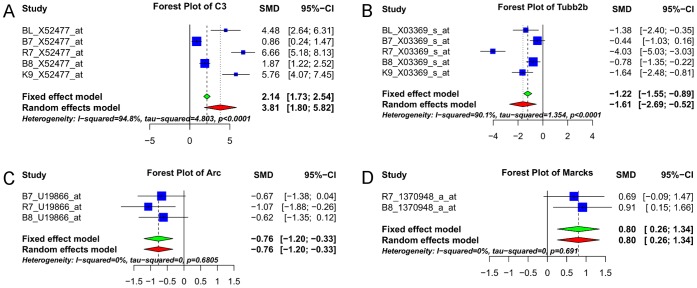
Forest plots of four representative significant genes.For the selected probe-set for each gene the individual study specific standardized mean differences (SMD) and their 95% confidence intervals (CI) are plotted and shown on each row. The effect size results are shown at the bottom of each plot. C3 is up-regulated (A) and Tubb2b is down-regulated in the aged rats. Arc is down-regulated (C) and Marcks is up-regulated (D) in the aged-impaired rats.